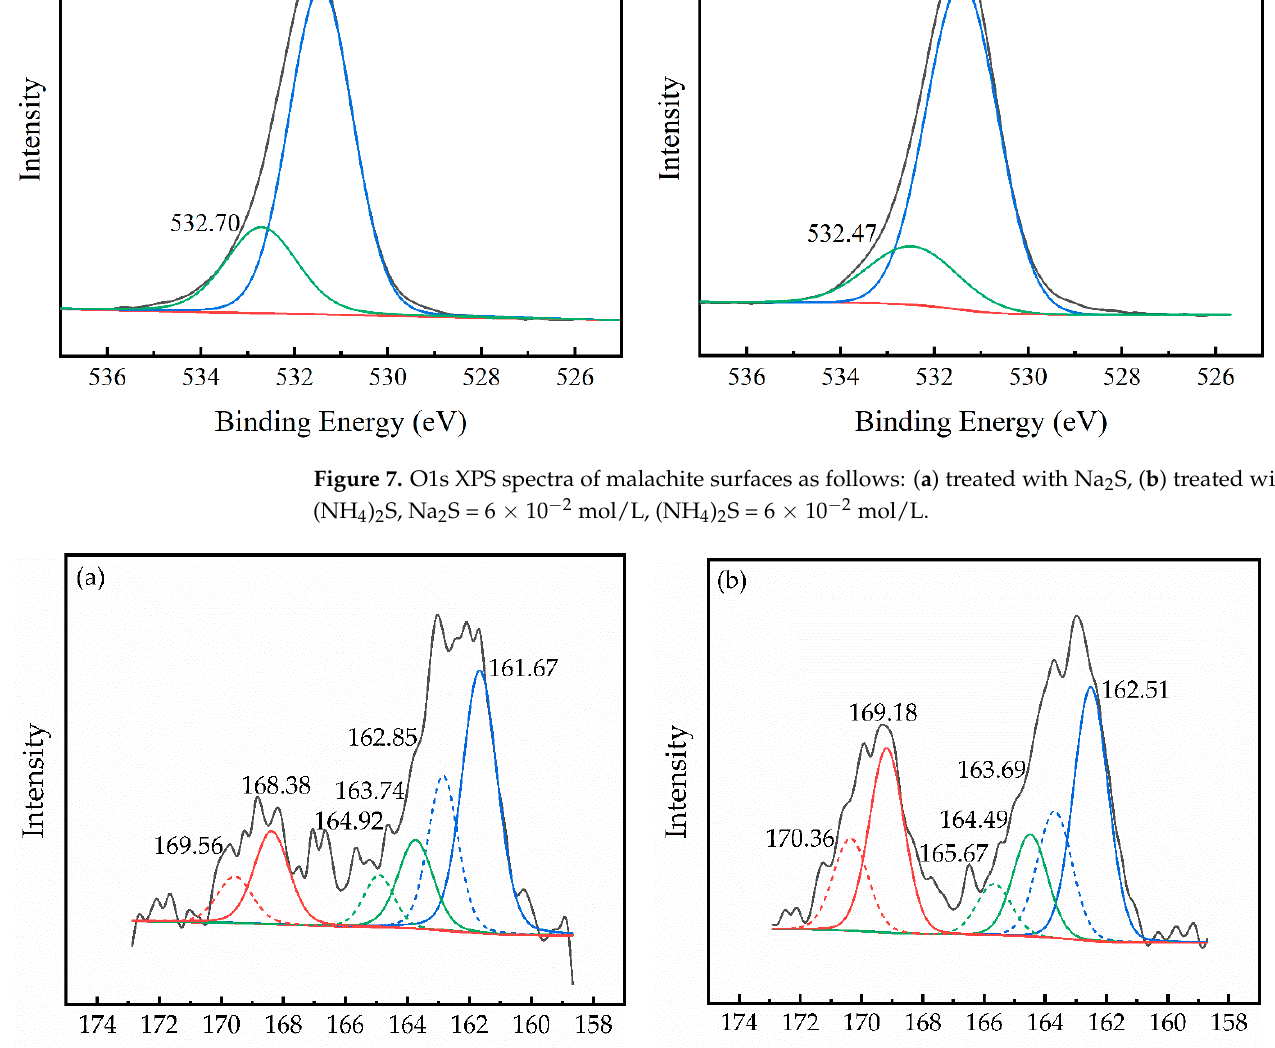
Figure 8. S 2p XPS spectra of malachite surfaces as follows: ( a ) treated with Na 2 S, ( b ) treated with (NH 4 ) 2 S, Na 2 S = 6 × 10 − 2 mol/L, (NH 4 ) 2 S = 6 × 10 − 2 Table 2. Binding energy and percentage in total S of different S species on (a) malachite + 0.06 M Na 2 S, (b) malachite + 0.06 M (NH 4 ) 2 S.